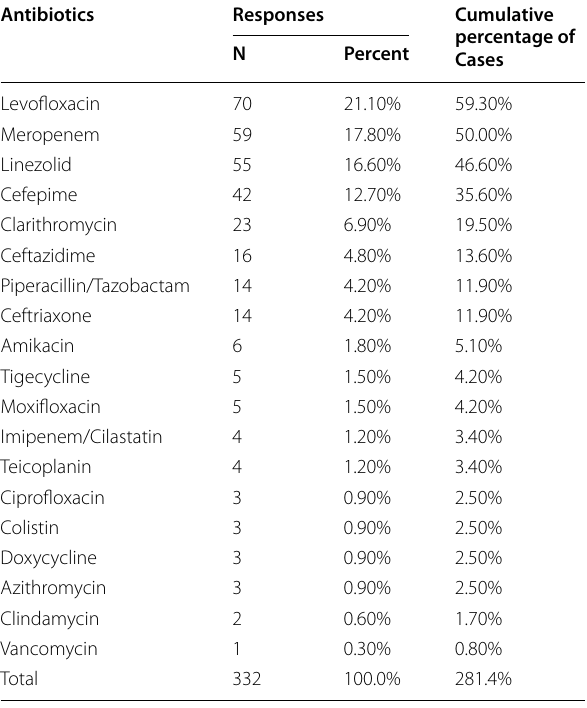
Table 4 Antibiotics prescribed to patients during ICU stay